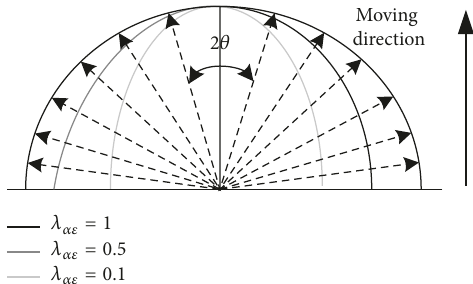
Figure 2: Possible speed directions and 𝐹 𝛼𝜀 after